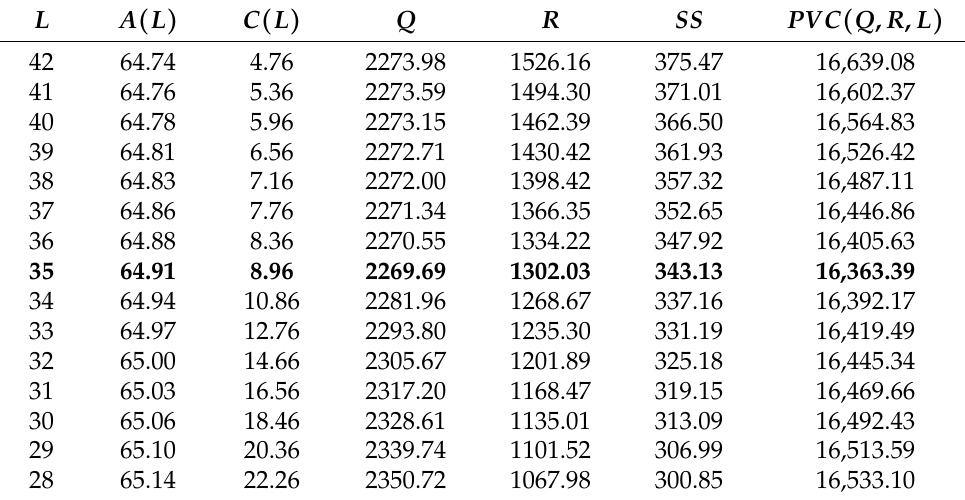
Figure 8. Plot of the total cost function for the fuzzy stochastic model. Table 5. Optimal solution for the stochastic